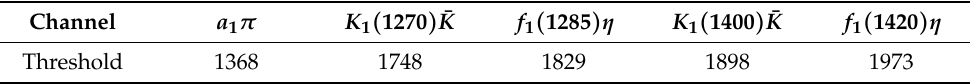
Table 1. J PC = 1 − + meson-meson channels with I = 0. The threshold masses are in the units of MeV.